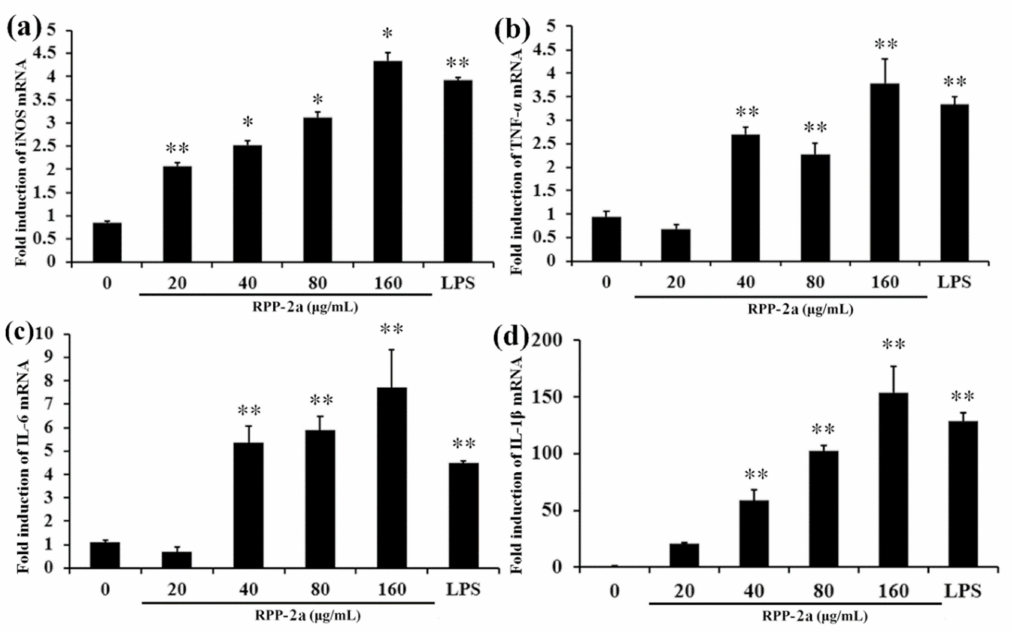
Figure 9. Effects of RPP-2a on the mRNA expression of iNOS and cytokines in RAW264.7 macrophages. The mRNA levels of ( a ) iNOS, ( b ) TNF- α , ( c ) IL-6, and ( d ) IL-1 β were measured by qRT-PCR in the RPP-2a treated RAW264.7 cells. Data are presented as mean ± SD, n = 3, * = p < 0.05, and ** = p < 0.01 vs. control